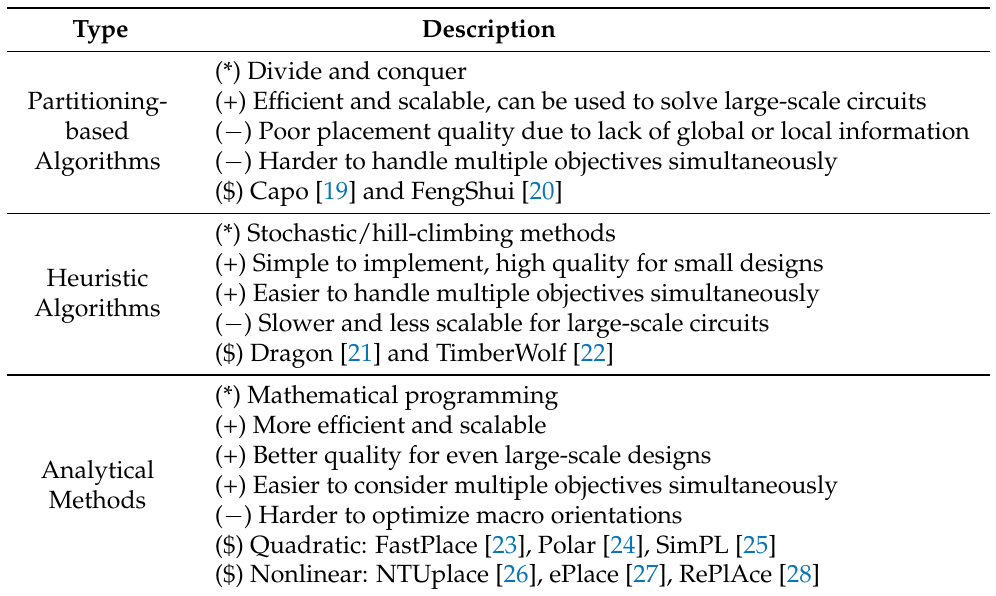
Table 1. The core ideas (*), strengths (+), and weaknesses ( − ) of the three types of algorithms and the corresponding typical placers